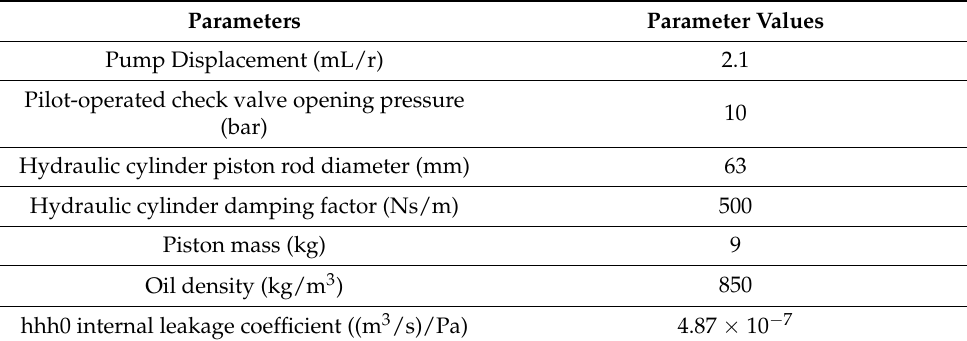
Table 2. EHA system simulation